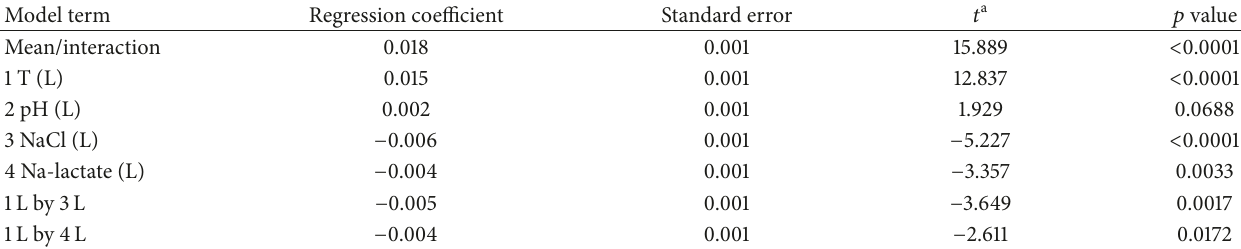
Table 4: Regression coefficient results from the results of the central composite rotatable design (CCRD).